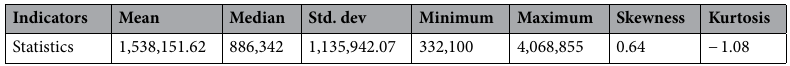
Table 1. Descriptive Statistics of the daily confirmed cases of COVID-19.